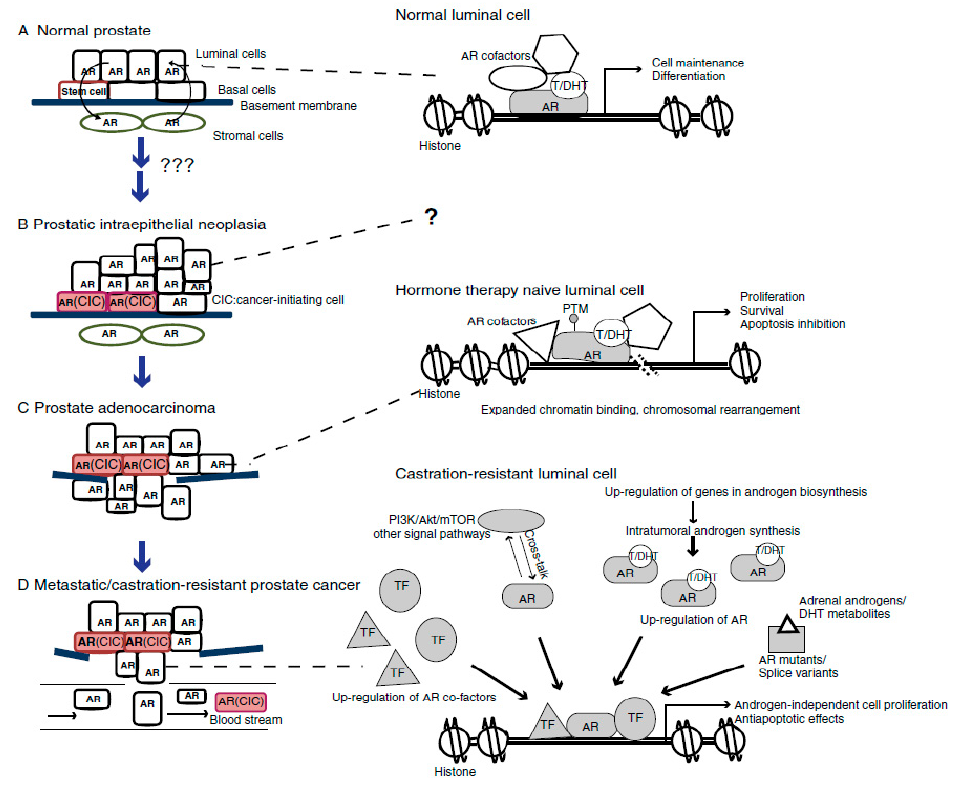
Figure 2. The function of AR signaling in prostate cancer and development: ( A ) Prostate homeostasis is maintained in a healthy prostate via reciprocal signaling between the stromal and epithelial layers; ( B ) normal prostate cells are converted into cancer initiating cells by unknown mechanisms, histological evidence of prostatic intraepithelial neoplasia and early cancer lesions appears, cells at the basal layer express higher levels of AR in response to this event; ( C ) cellular and molecular alterations occur in prostate adenocarcinoma, resulting in luminal cells with the AR transcriptional pathway; ( D ) Prostate cancer cells in CRPC maintain AR activity through other mechanisms (in- cluding upregulation of AR and its splice variants, intra-tumoral androgen synthesis, cross com- municate with other signal pathways, and increased/altered expression of AR cofactors) as the avail- ability of androgen from the blood steam becomes limited [134].